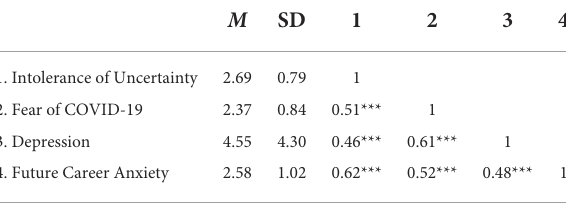
TABLE 1 Correlations between variables ( N =